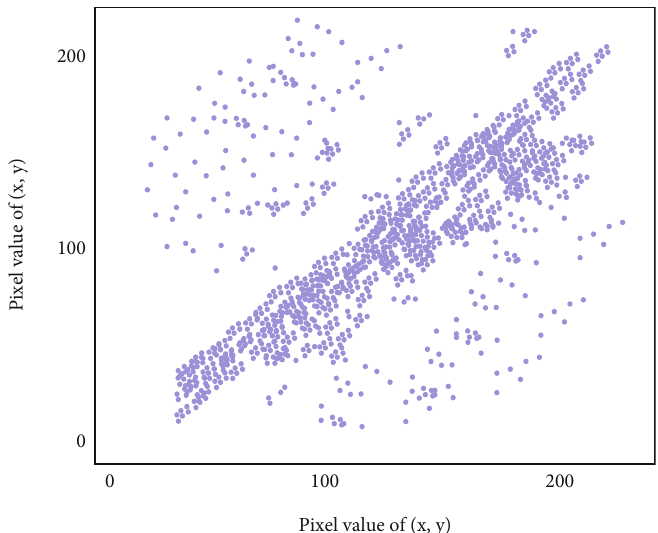
Figure 4: Lateral correlation distribution of Lena